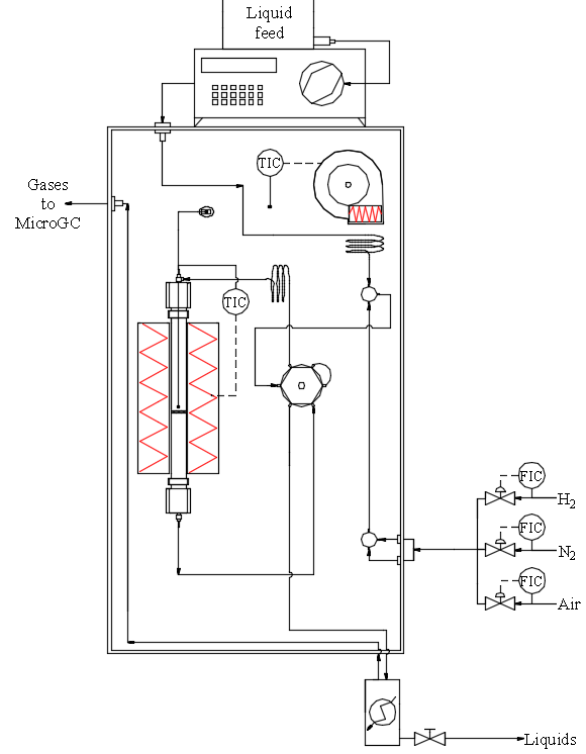
Figure 10. Schematic diagram of the testing system [55]. The outlet gas composition is measured online using an Agilent 490 Micro-GC equipped with a thermal conductivity detector (TCD), a Pora Plot U column (10 m), and a Molecular Sieve 5A column (20 m) using He and Ar as the carrier gas, respectively. Condensable vapors were trapped in the condenser and subsequently analyzed in a Varian CP-3900 chromatograph equipped with a CP-WAX 52 CB column and flame ionization detector (FID), using 1,4-butanediol as an internal